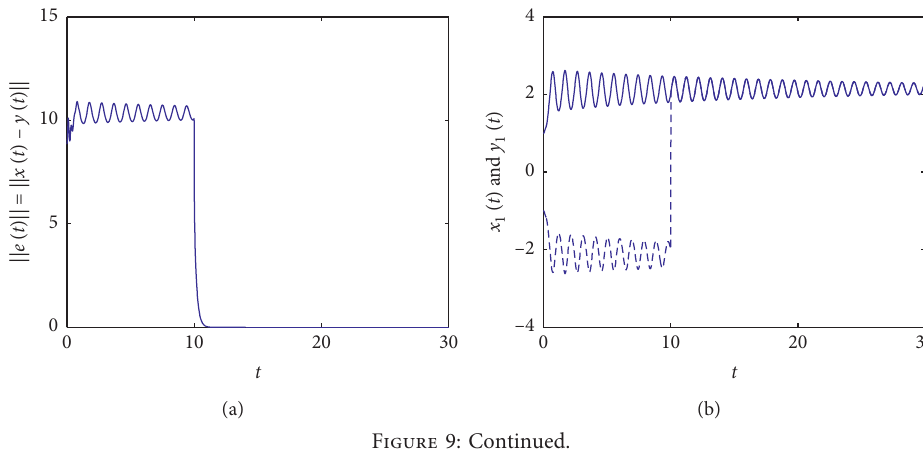
Figure 8: A static sliding mode control of the asymptotically stable state regime at the Reynolds number R periodic regime at R e � 24 in the master system (7). The controller is switched on at time t � 10. (a) The L ( t ) and y ( t ) versus time. (c) The states x (b) The states x 1 1 showing how the controller drives the states from one attractor to another